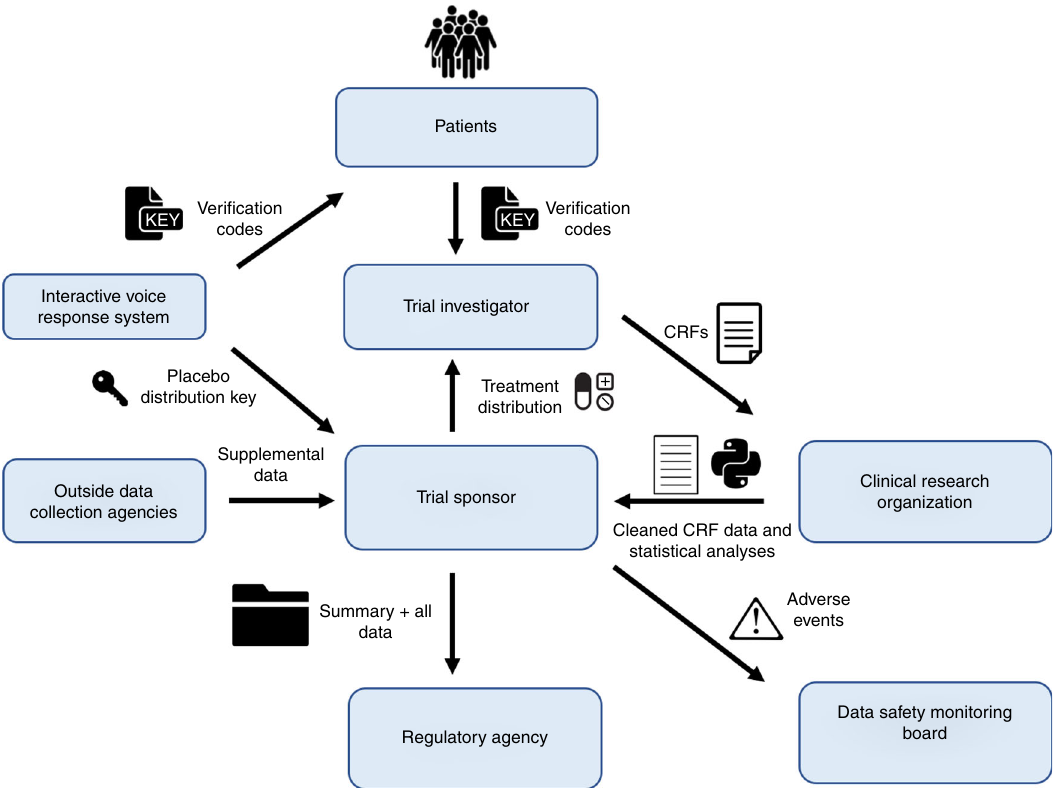
Fig. 1 The idealized clinical trial network in the context of a blockchain-based record system. The various transactions (along each arrow) and key participants (boxed) within a clinical trial are